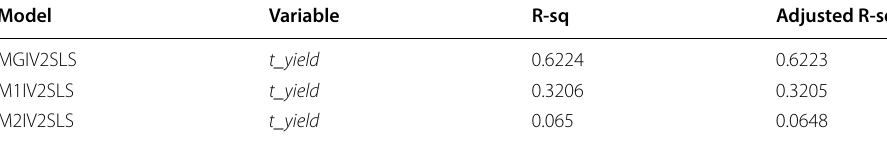
.estat firststage